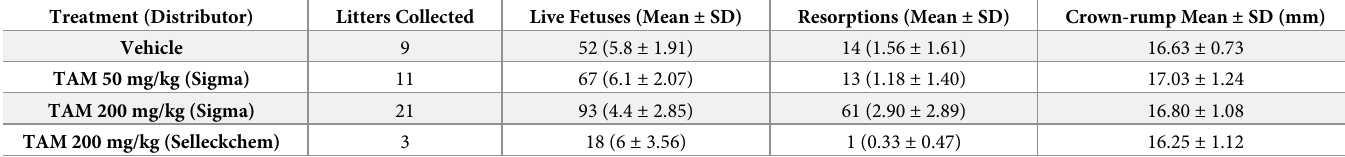
Table 1. Descriptors of the wildtype C57BL/6J study population found in Fig 2.